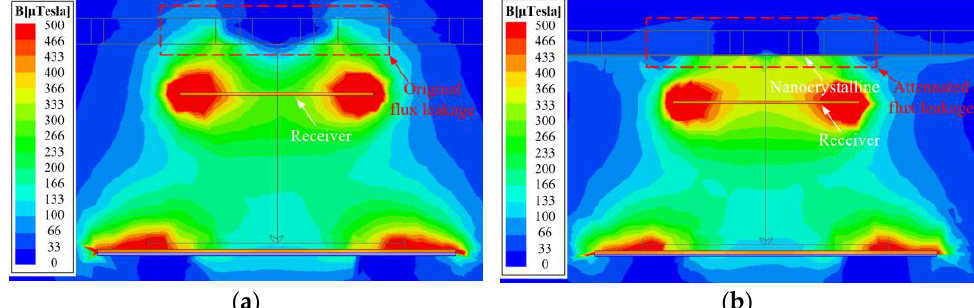
Figure 10. Flux leakage with and without nanocrystalline. ( a ) Without nanocrystalline and ( b ) with nanocrystalline.